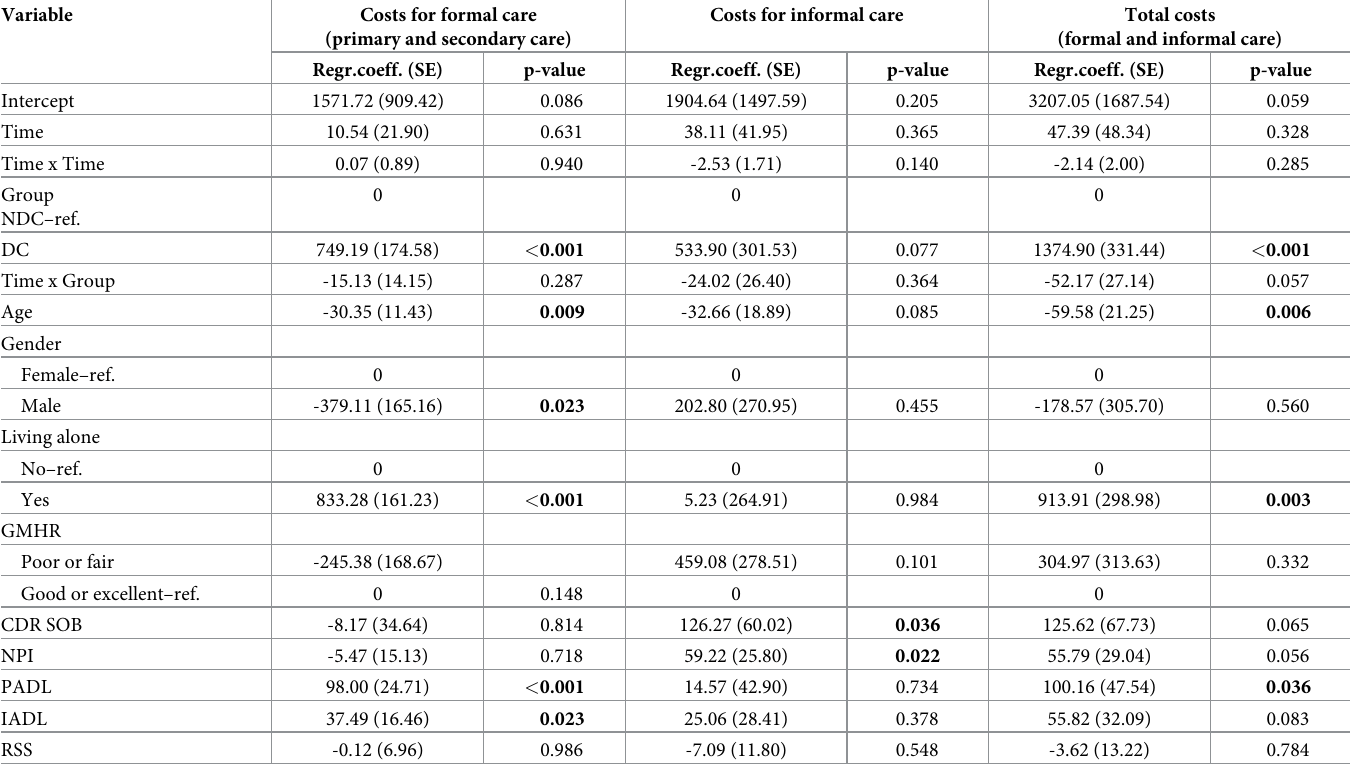
Table 3. Results of linear and generalized linear mixed